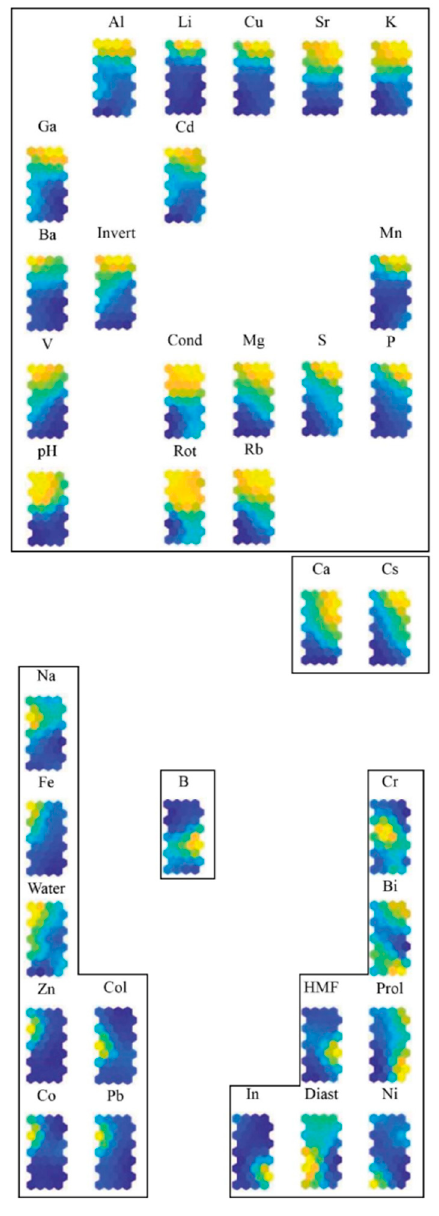
Figure 2. Ordering of variable planes in five main clusters. The abbreviations of the analytes are described in Section 4.3.